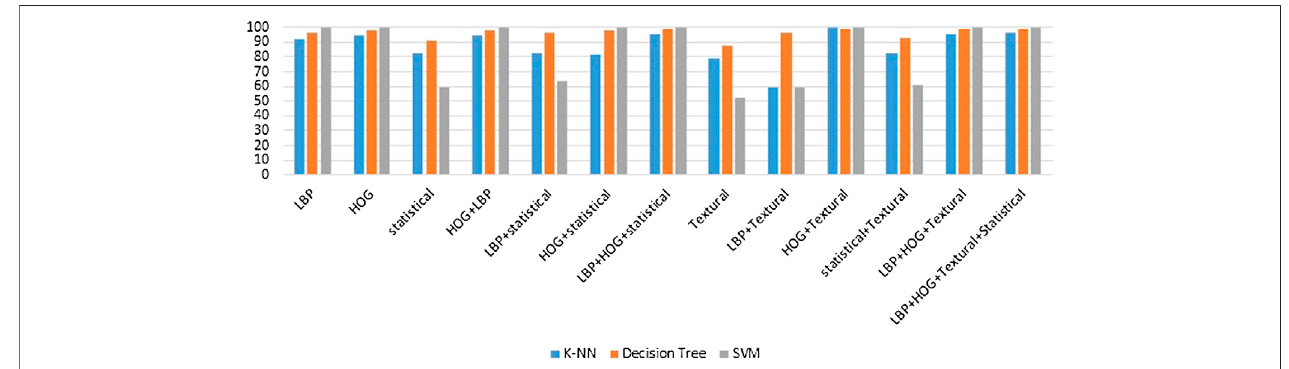
FIGURE 5 | Graphical representation of features and classi fi ers.